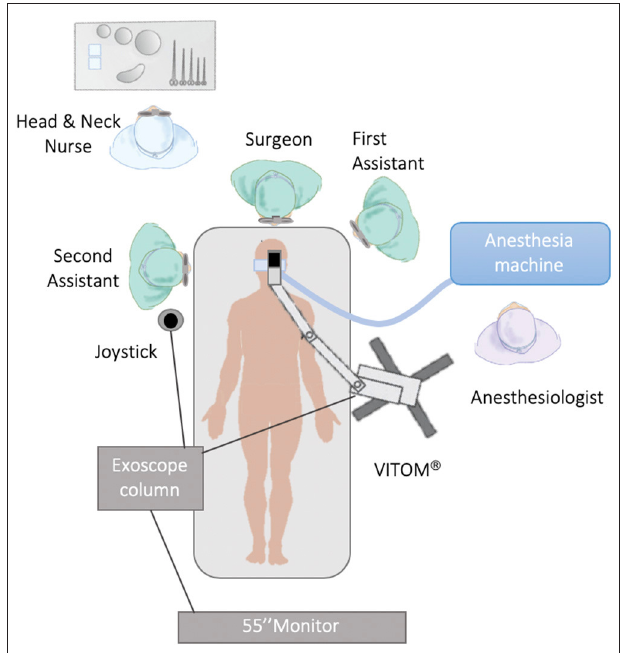
FIGURE 1 | Operating room setting (VITOM ®